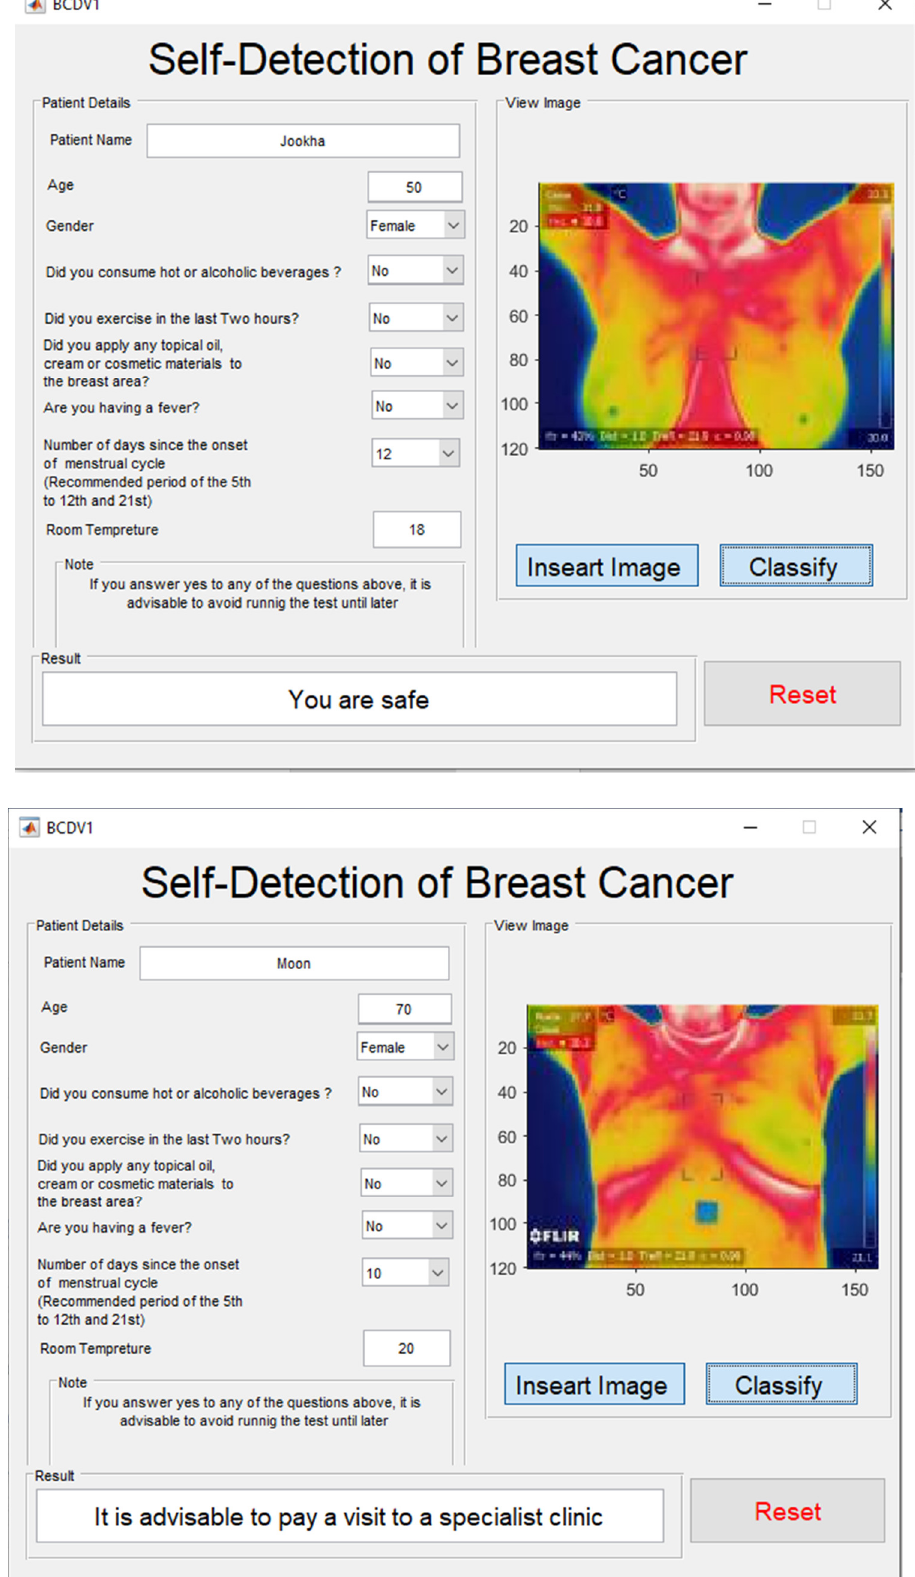
Figure 5. Diagnostic results on the application interface.